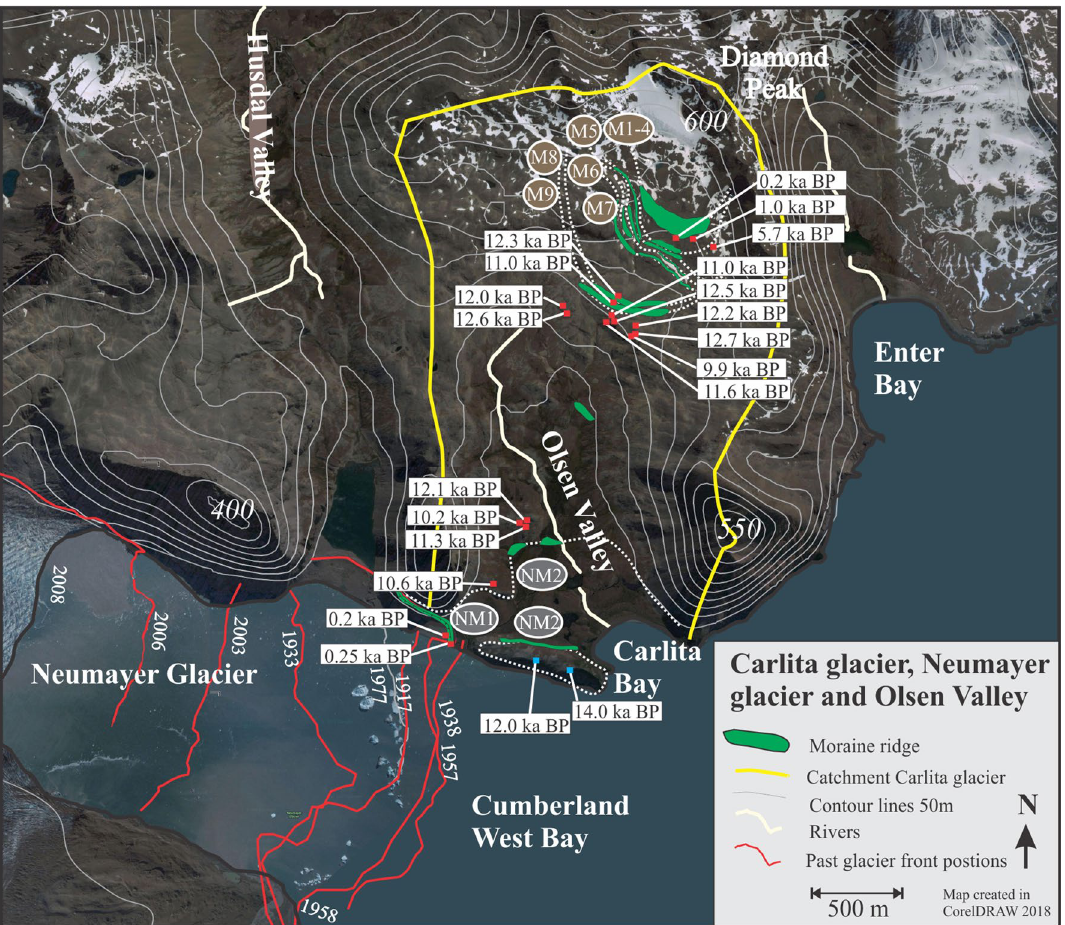
Figure 6. The study area in Cumberland West Bay, including the rapidly retreating glacier front of Neumayer Glacier and the much smaller Carlita Glacier lying in the uppermost part of Olsen Valley. The red lines are the historically documented frontal positions of Neumayer Glacier 44 . Red dots indicate sampling sites for cosmogenic dating, and the connecting ages are marked in white